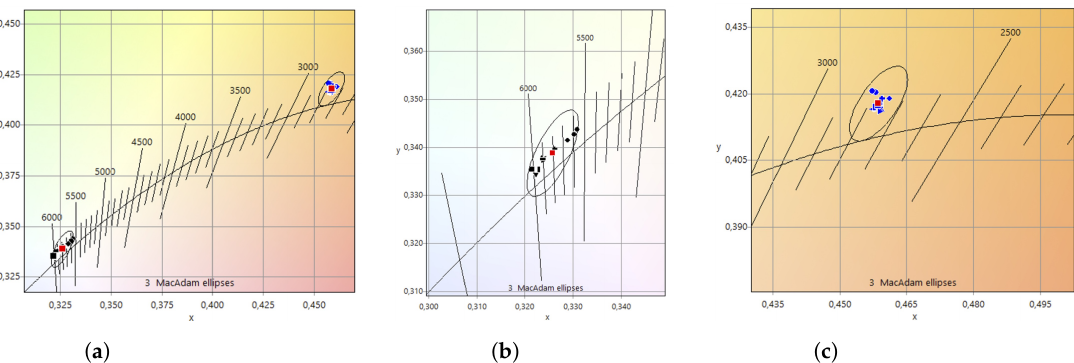
Figure 6. The LED light sources distribution in the CIE 1931 graph: ( a ) powering at 100% first only the cool LEDs and then only the warm LEDs, in red the average of the samples; ( b ) zoom of cool channel; ( c ) zoom of warm